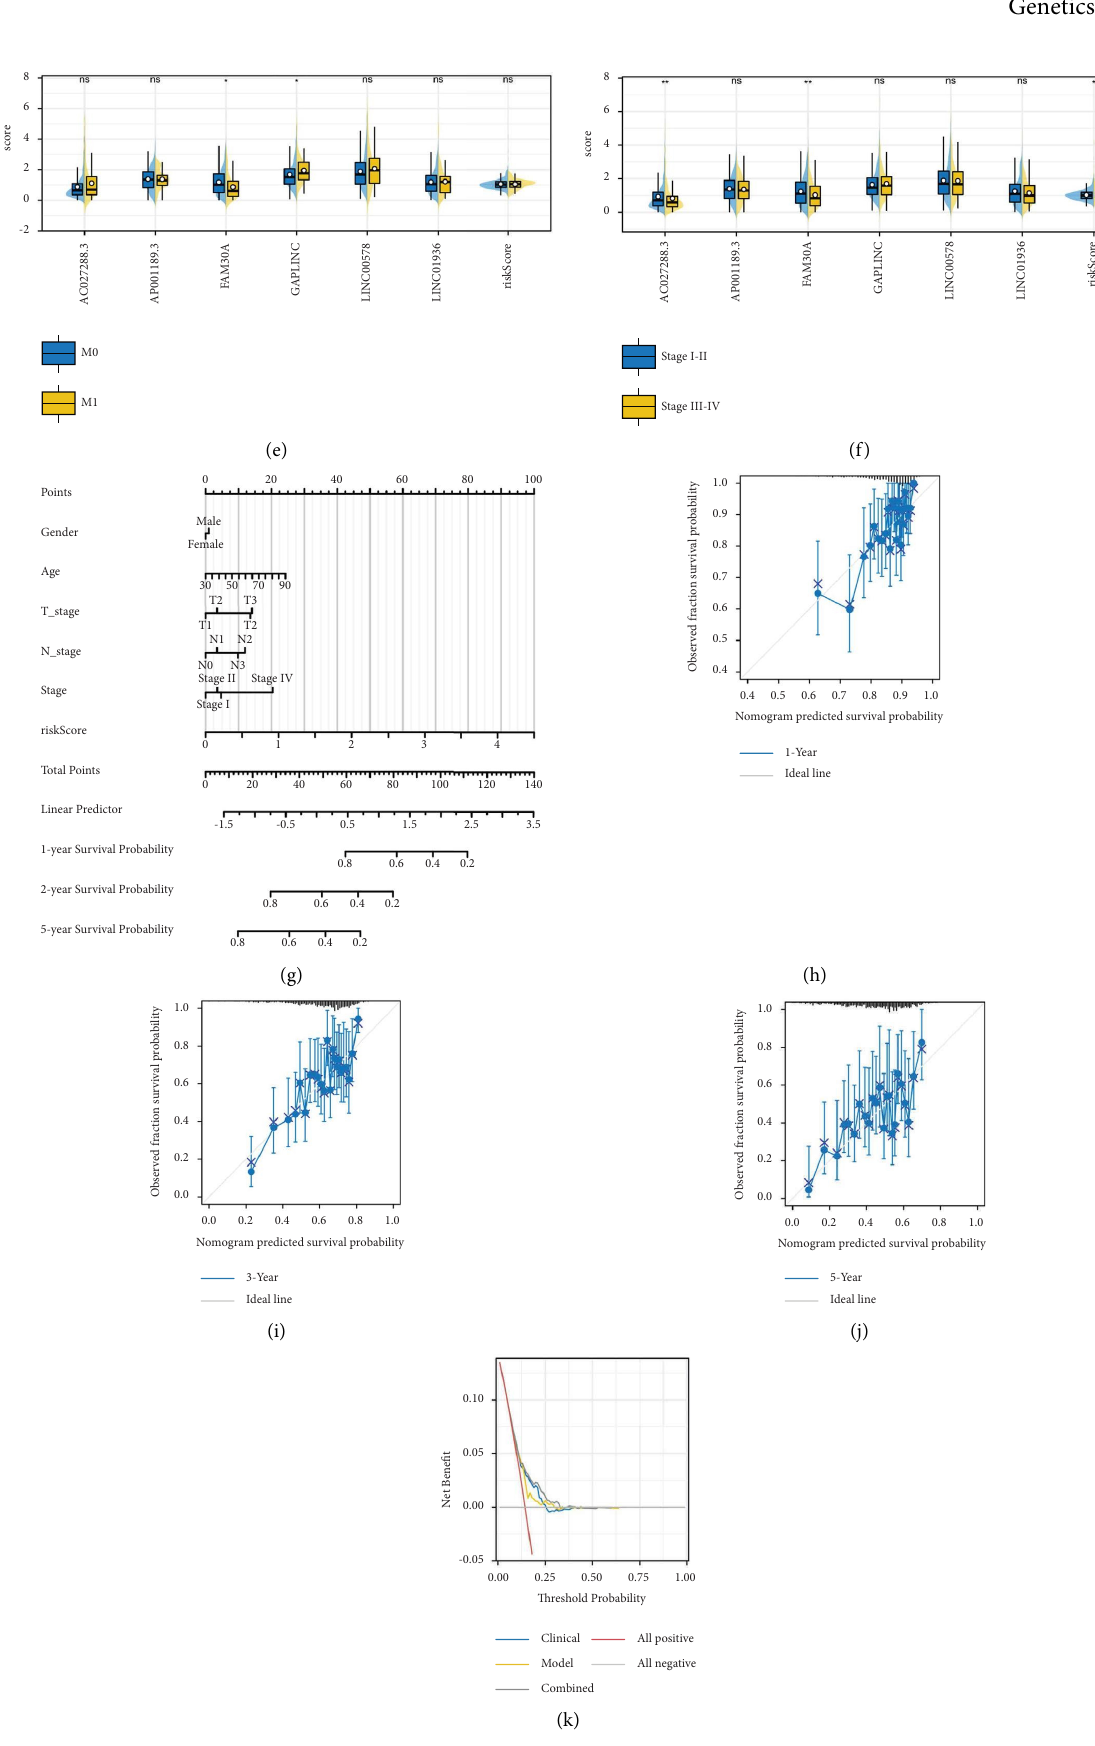
Figure 4: Clinical correlation analysis and nomogram. (a)–(f) Te level of model lncRNAs and risk score in patients with diferent clinical features, ns � P > 0 . 05, ∗ � P < 0 . 05, ∗∗ � P < 0 . 01, ∗∗∗ � P < 0 . 001; (g) a nomogram plot combining risk score and clinical features; (h)–(j) the 1, 3, and 5years calibration curves of nomogram; (k) DCA curve of the